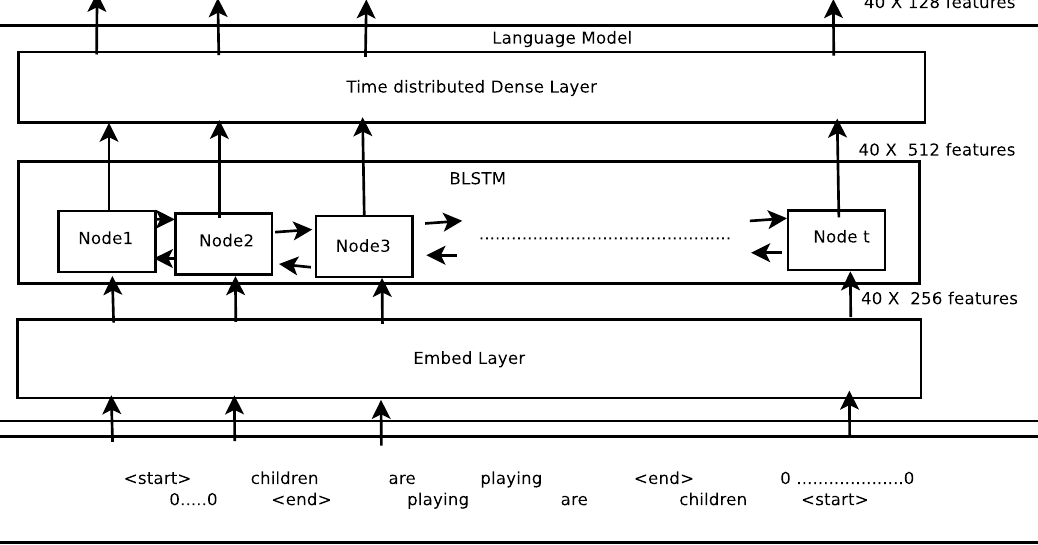
Figure 4. Architecture of the language